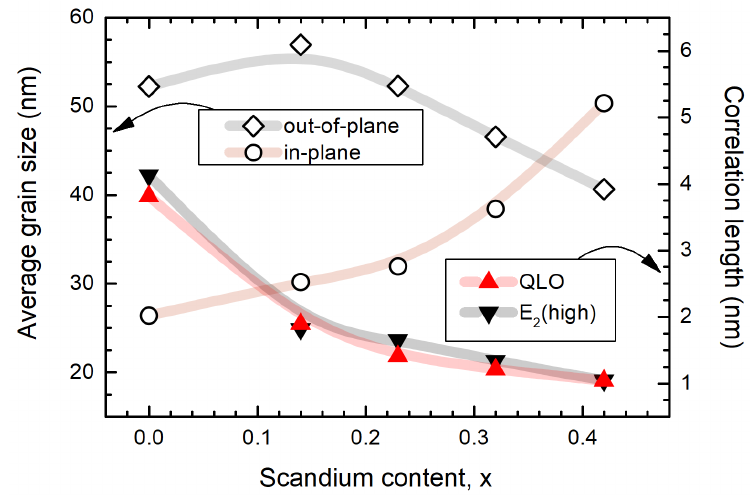
Figure 5. Average grain size and phonon correlation length as a function of the Sc content in the AlScN films. The continuous lines are given as guides to the